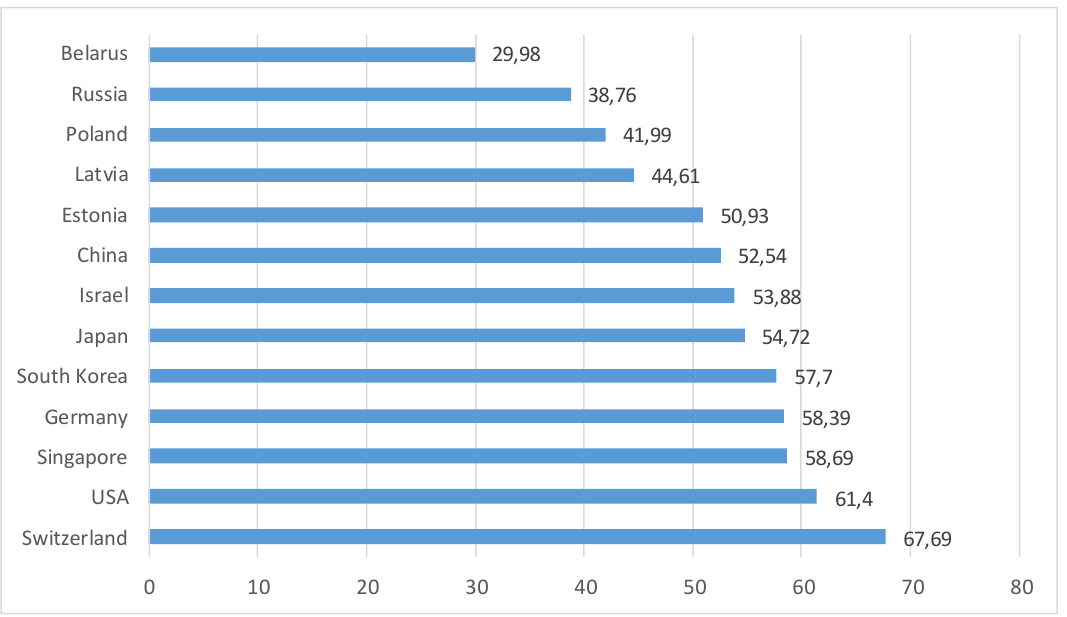
Figure 1: Global innovation index by country,